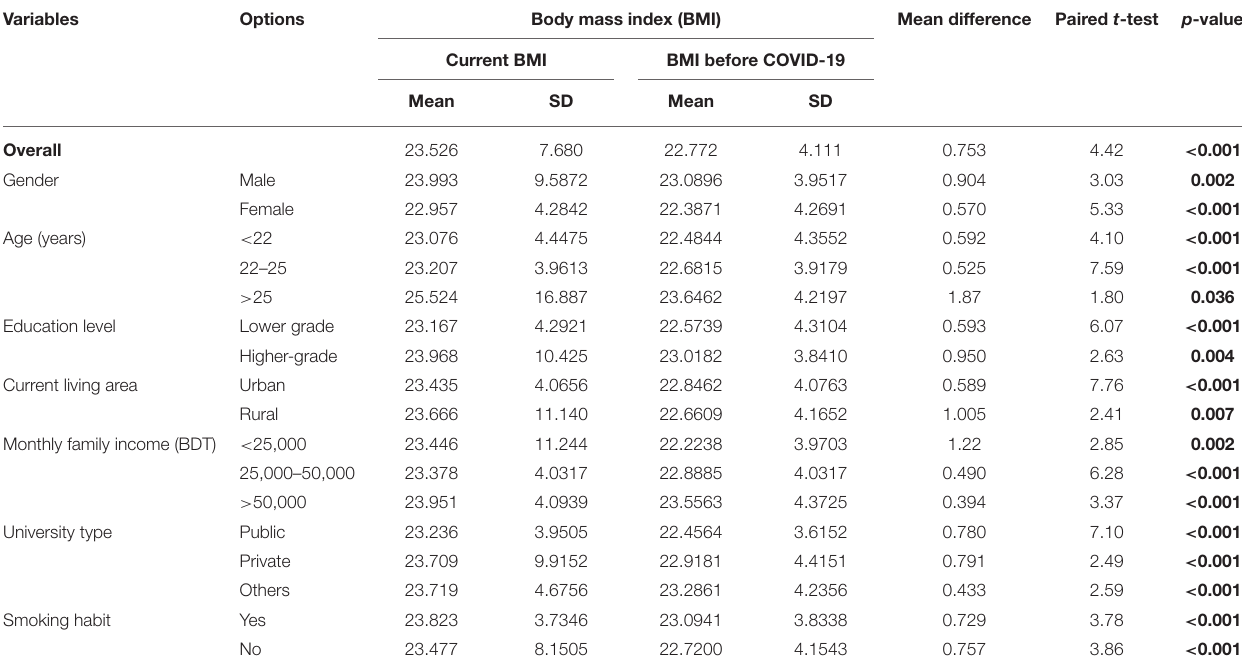
TABLE 1 | Descriptive statistics of body mass index (BMI) before and during COVID-2019 lockdown by different socio-demographic characteristics (p-value obtained from paired t-test).